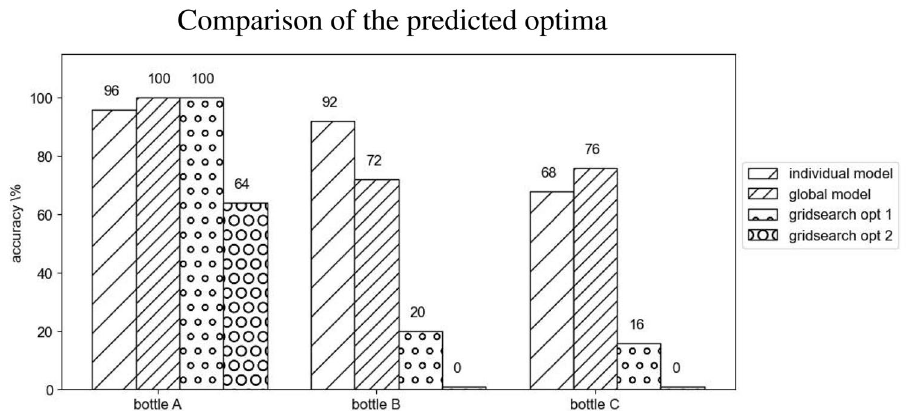
Figure 4. Accuracy of the optima predicted by each method.